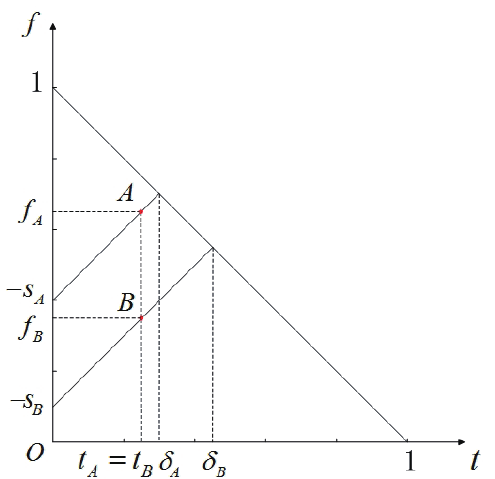
Figure 2. The equivalence of the orders ≤ ( t , s ) , ≤ ( t , f ) and ≤ ( t , δ )